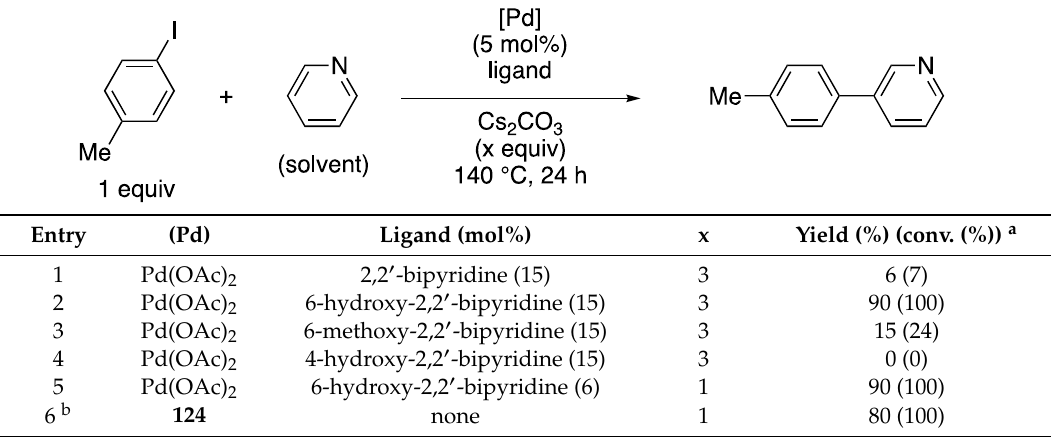
Table 4. Effect of hydroxypyridine ligand on Pd-catalyzed direct arylation of pyridine.